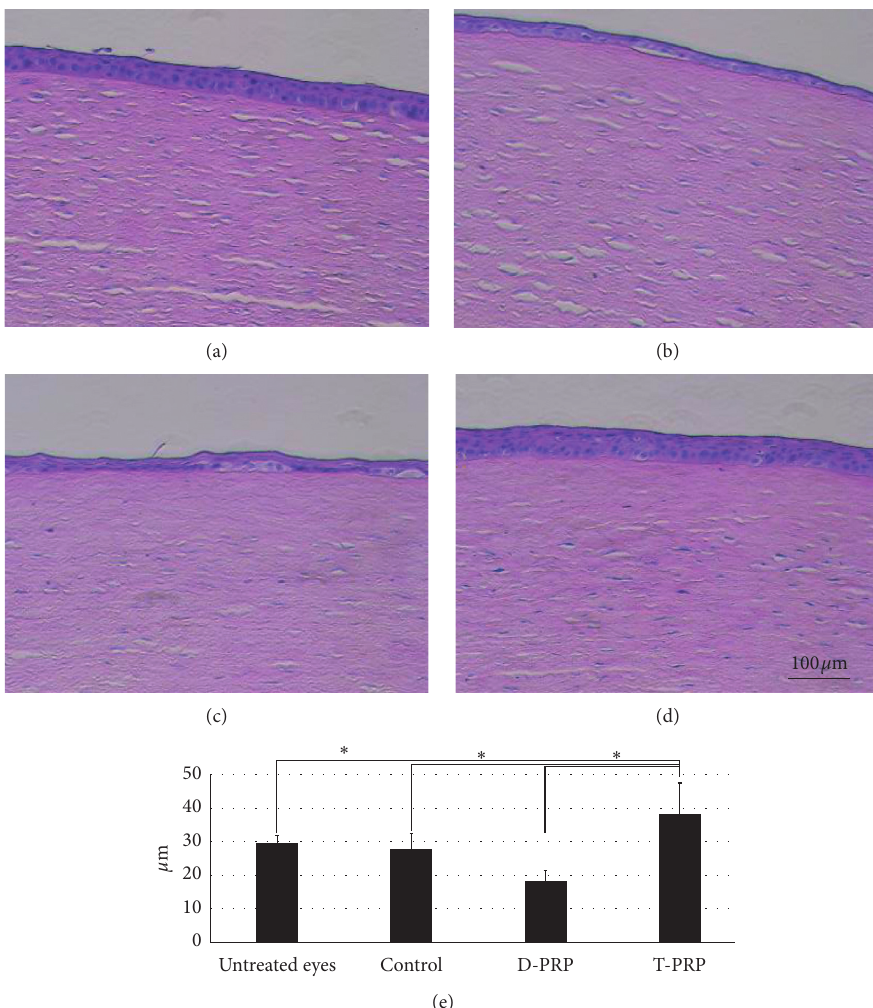
Figure 4: Histology of the cornea after complete wound healing. (a) Untreated eye, (b) eyes treated with control, (c) eyes treated with D- PRP, (d) eyes treated with T-PRP, and (e) thickness of the epithelial layer; ∗ P < 0.05; n �